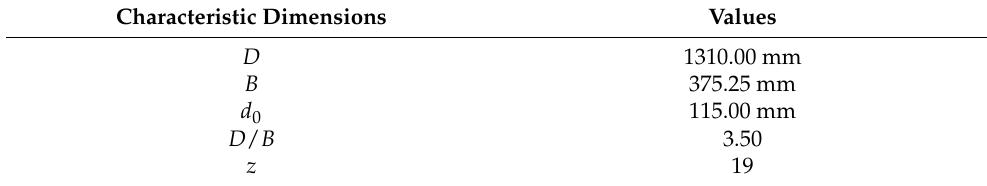
Table 1. Main dimensions of the turbine. Characteristic